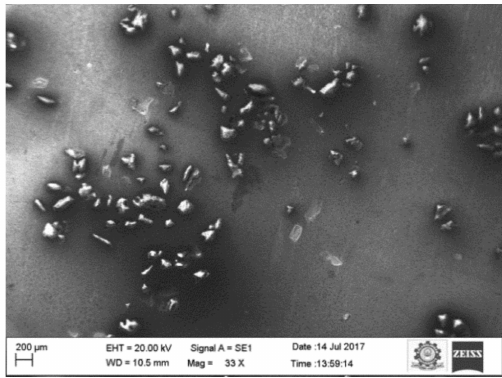
Figure 1. SEM image of 10 wt.% aluminum sillimanite reinforced